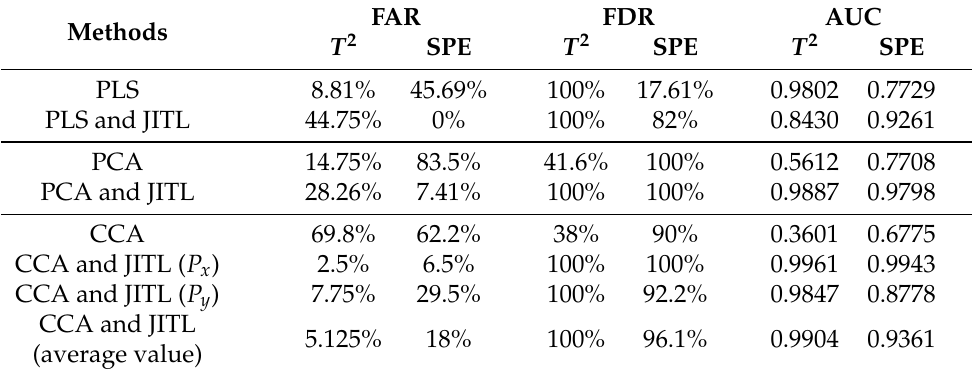
Table 1. Online Testing Results of FD models.